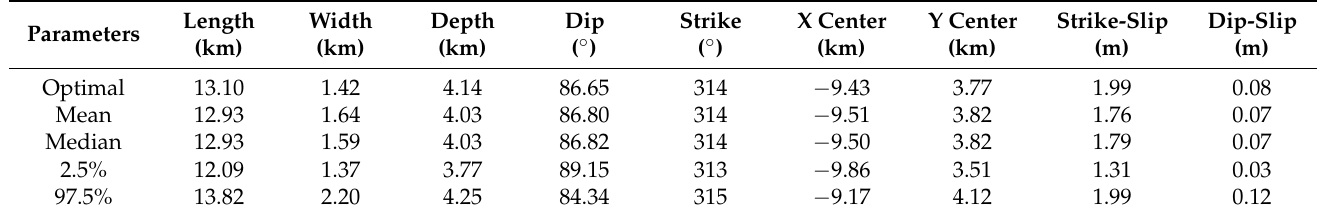
Table 3. The inferred fault geometry parameters of the 2021 Yangbi earthquake.